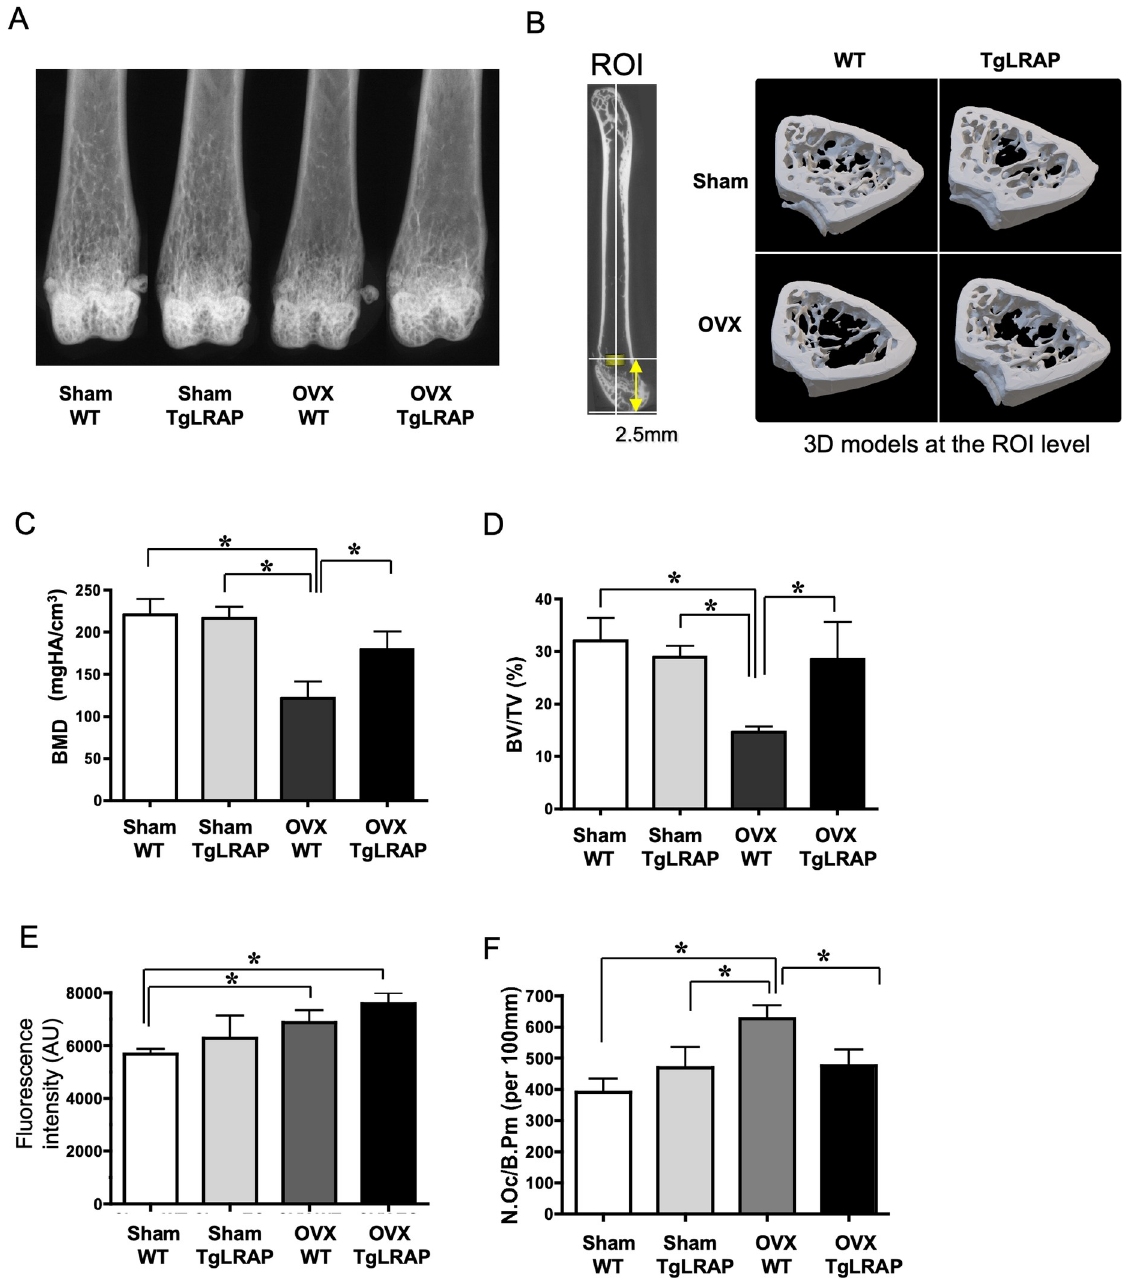
Fig 5. TgLRAP mice resisted bone loss induced by ovariectomy (OVX). A, Fine focused radiographic analysis of femur. OVX WT showed decreased trabecular bone structures compared to other groups. B, 3D μ CT evaluations of bone parameters. The left panel indicates the region of interest (ROI; yellow cylinder) for following measurements. The right panel indicates the tomography at the level of ROI. C and D , Parameters analyzed by μ CT. BMD and BV/TV were decreased in OVX WT compared to other groups. BMD; bone mineral density. BV/TV; ratio of trabecular bone volume per total bone volume, each column represents the mean ± SD. n = 4 for each group. E, Quantitation of calcein incorporation into the calvaria. AU; arbitrary unit. Each column represents the mean ± SD. n = 4 for each group. F, Histological quantitation of bone resorption in sham-operated (Sham) /OVX WT or TgLRAP mice. The number of osteoclasts per bone perimeter (N. Oc/B.Pm (per 100 mm)) were compared. Each column represents the mean ± SD. n = 4 for each group. � p < 0.05. WT; wild-type mouse, TgLRAP; LRAP transgenic